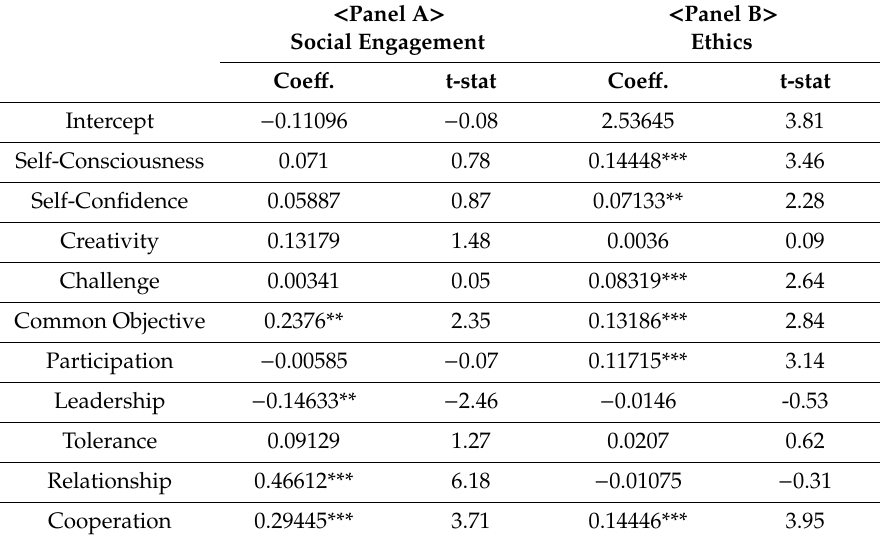
Table 7. E ff ects of Personal Values on CSV